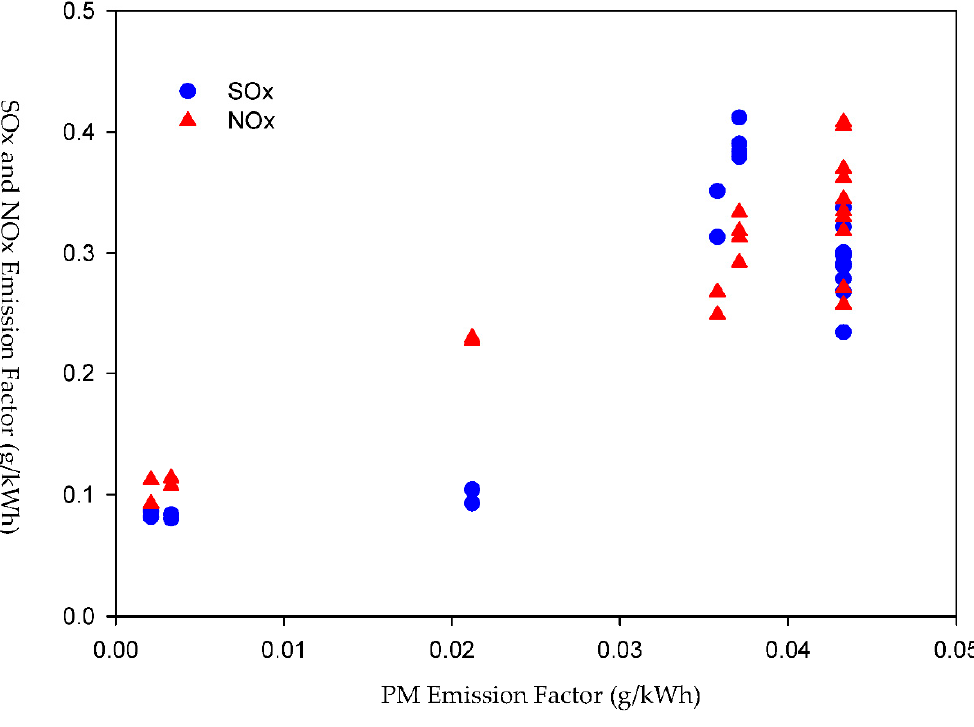
Figure 6. Relationships among PM, SOx, and NOx emission factors for coal-fired power generation units.